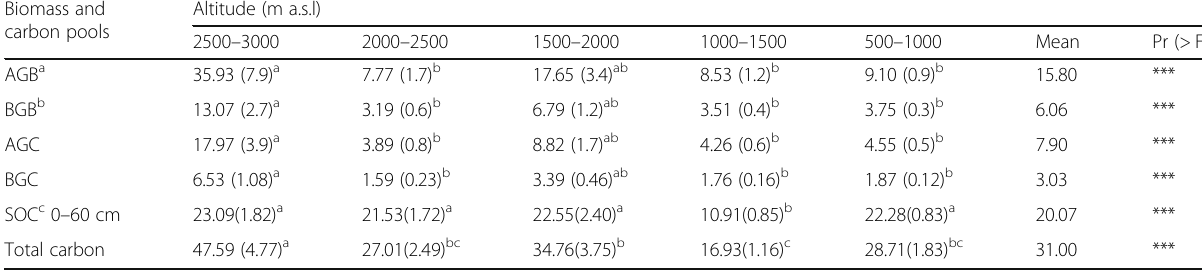
Table 3 Mean (± standard error; n = 15) biomass (Mg ha − 1 ), biomass carbon, soil carbon (SOC), and total carbon (total biomass plus SOC 0 – 60 cm) carbon stocks (Mg C ha − 1 ) for each of the five altitudinal gradient class and results of one-way ANOVA (at α = 0.05, significant differences between altitudinal gradient for any of the C stocks were indicated) Biomass and carbon pools